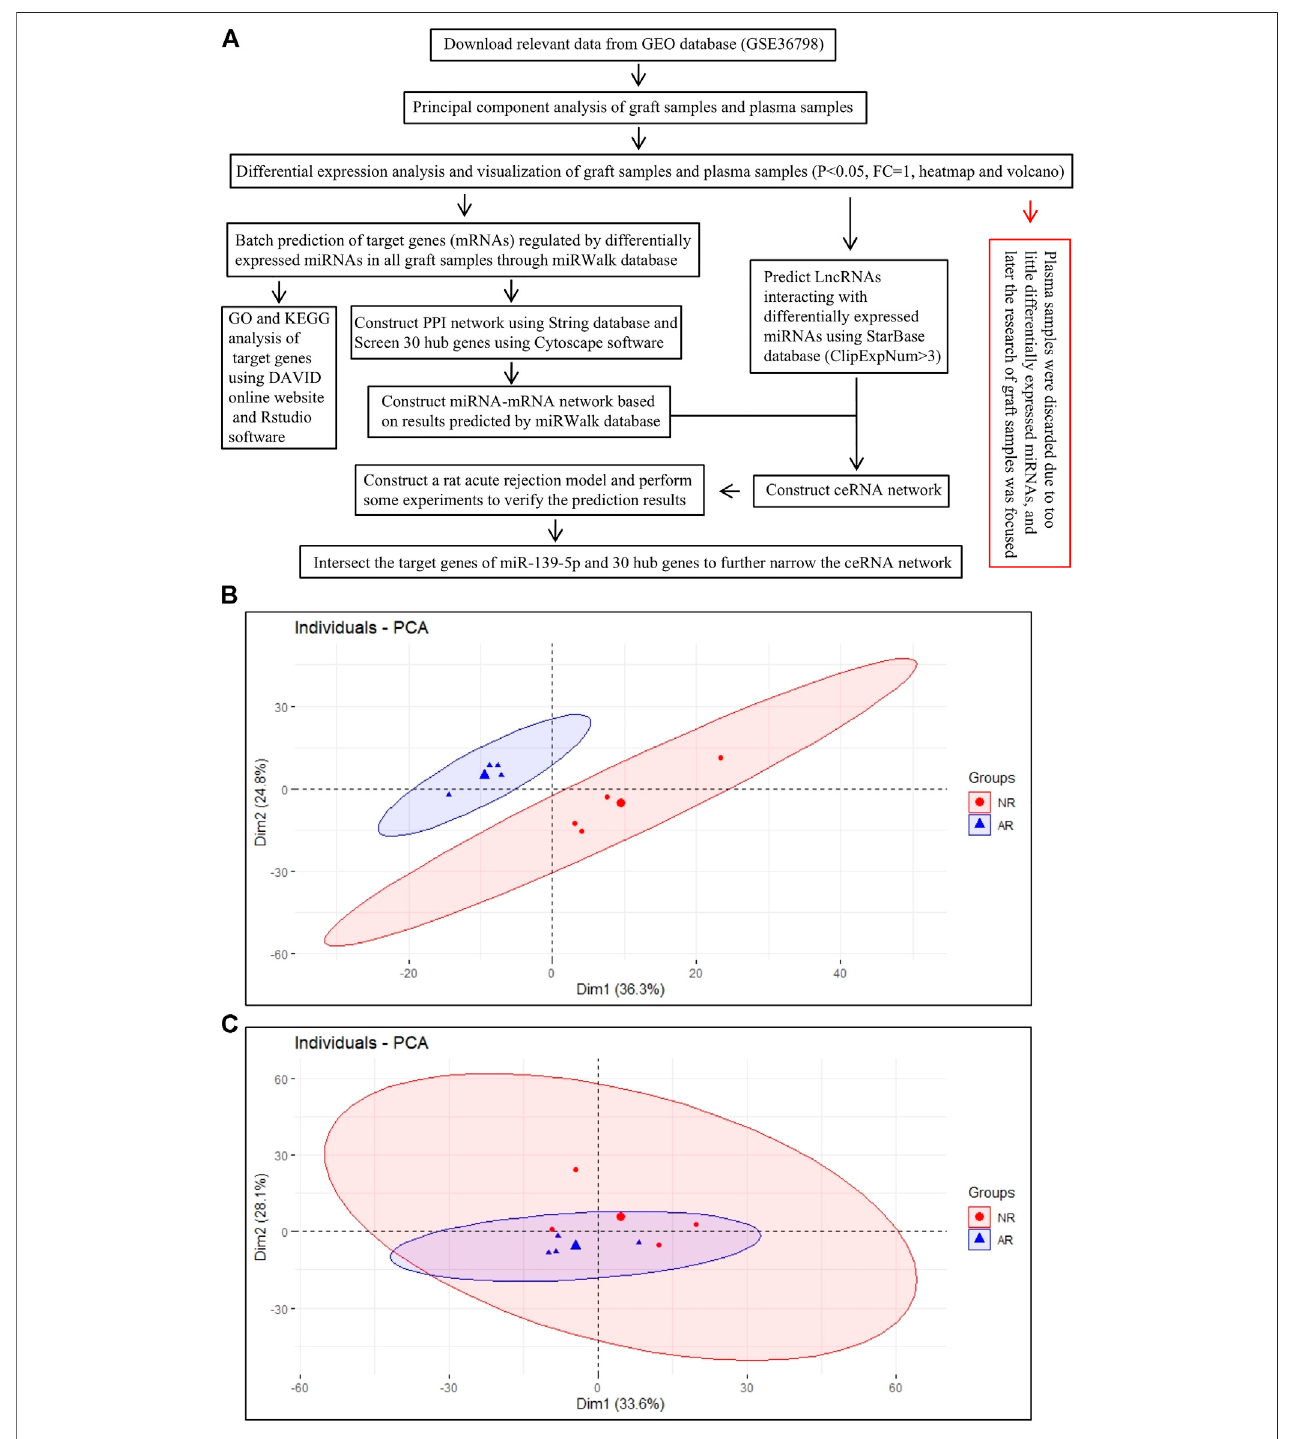
FIGURE 1 | Analysis process of the work. (A) Overall work fl ow chart. (B) PCA draft of graft samples. (C) PCA draft of plasma samples. Each small dot (triangle or circle) represents one sample, and the large dot represents the average of samples.